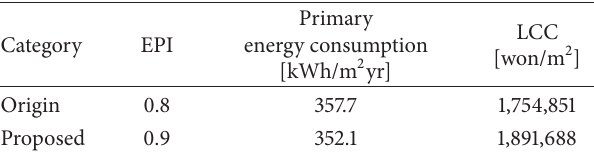
Table 9: Selected alternative when considering the EPI preferen-